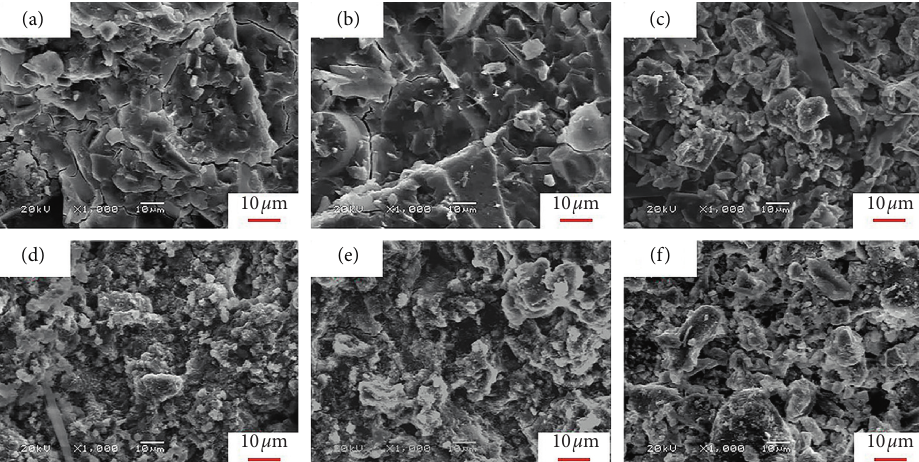
Figure 7: SEM micrographs of AAS at 3 d curing time. (a) A0S10-5M; (b) A2S8-5M; (c) A4S6-5M; (d) A6S4-5M; (e) A8S2-5M; (f) A10S0- 5M.